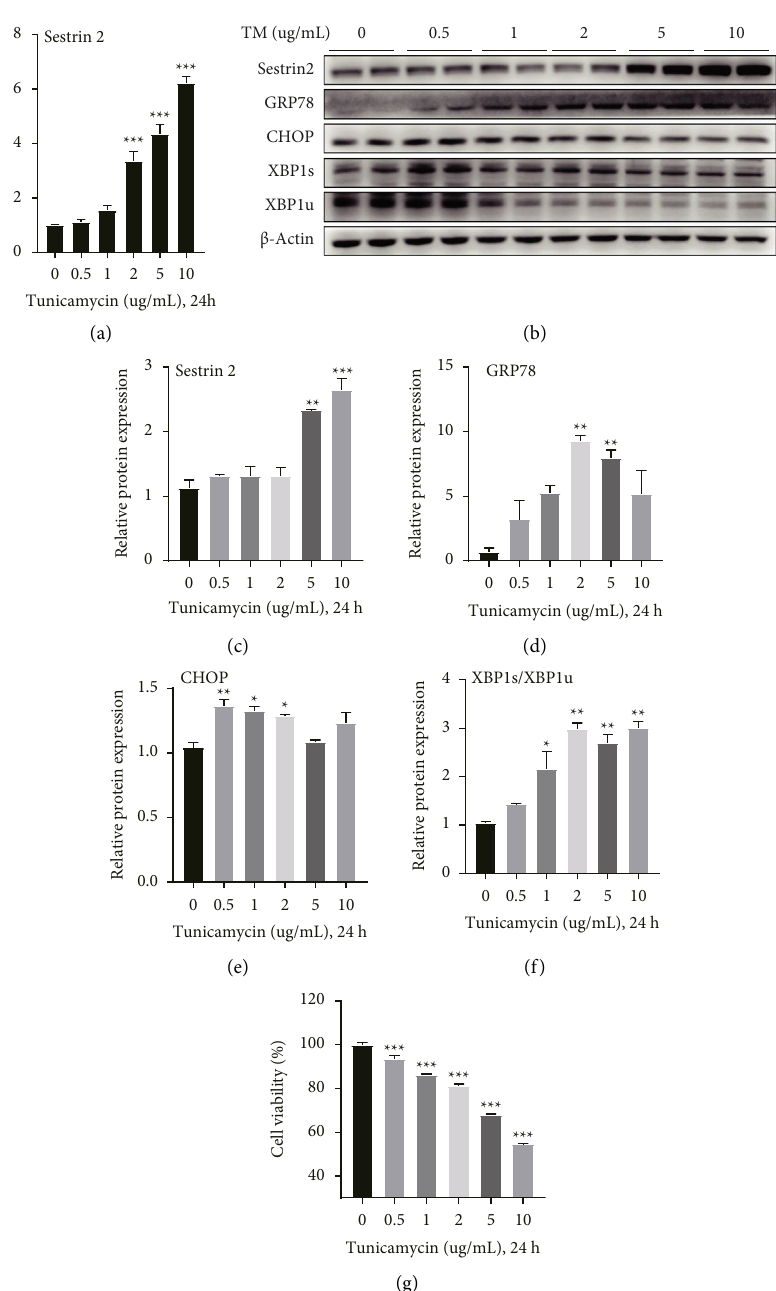
Figure 1: TM treatment-induced Sestrin2 up-regulation and ER stress. (a) mRNA level of Sestrin2 treated with various concentrations of TM (one-way ANOVA, Dunnett t post hoc test; F (5, 18) � 7.62, P < 0 . 001). (b) Representative western-blot results show Sestrin2 expression and proteins involving ER stress, such as GRP78, CHOP, XBP1s, and XBP1u. (c–f) Western blot quantitative analysis of Sestrin2 and proteins involving ER stress (one-way ANOVA, Dunnett t post hoc test; for Sestrin2: F (5, 6) � 27.27, P < 0 . 001; for GRP78: F (5, 6) � 8.97, P � 0 . 009; for CHOP: F � 9.12, P � 0 . 009; for XBP1s/XBP1u: F � 20.27, P � 0 . 001). (g) Viability of HepG2 cells with diferent TM (5, 6) (5, 6) concentrations treatment (one-way ANOVA, Dunnett t post hoc test; F (5, 18) � 291.97, P < 0 . 001). ∗ P < 0 . 05, ∗∗ P < 0 . 01, ∗∗∗ P < 0 .